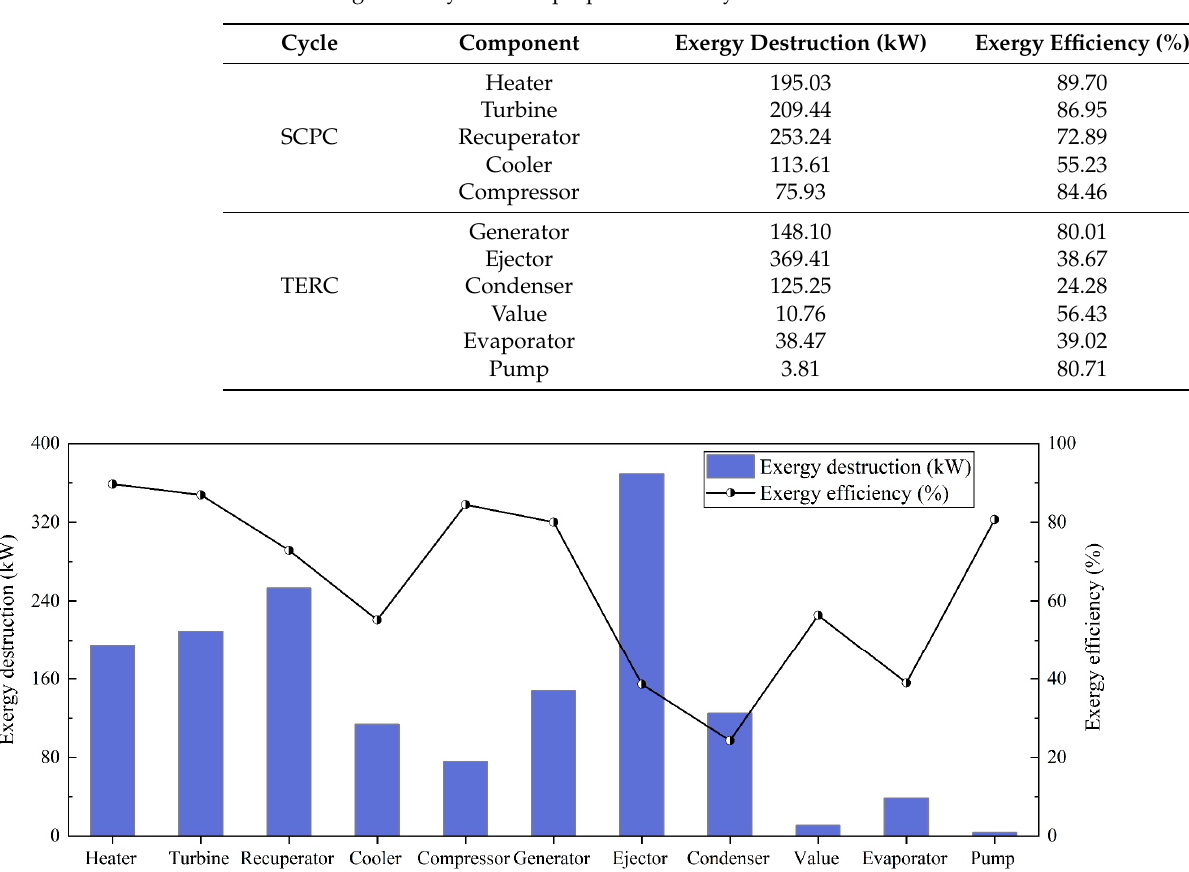
Table 7. Exergetic analysis of the proposed WHR system.